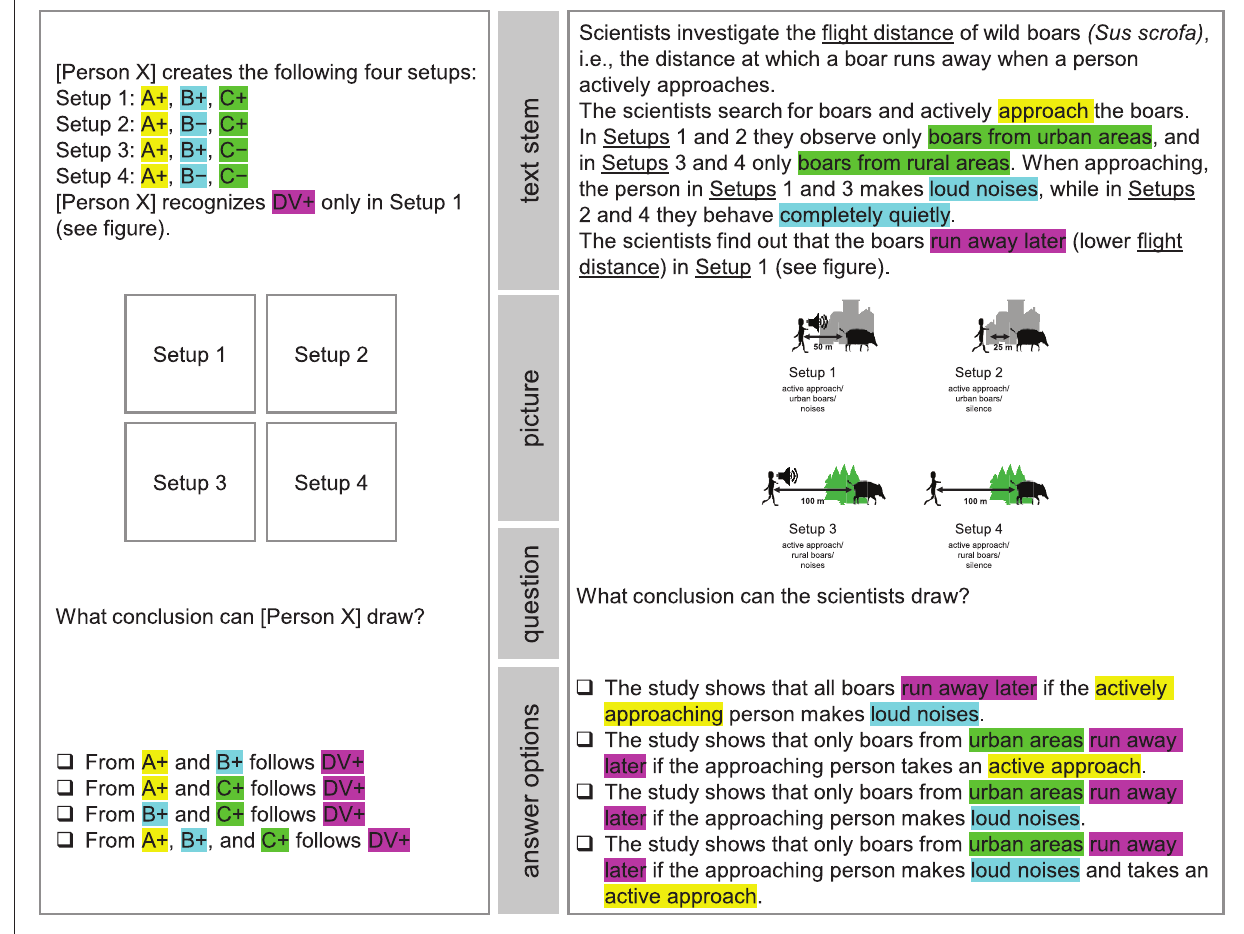
Figure 1 Example of the structure of an item in the blueprint (deep-structure item feature: analyzing data, high item complexity) and its adaptation for Item 6 in the SRQ (item surface feature: context of urban wildlife ecology). Color coding represents the corresponding variables in the blueprint ( left ) and the example ( right ). Underlined words are specialist terms in this